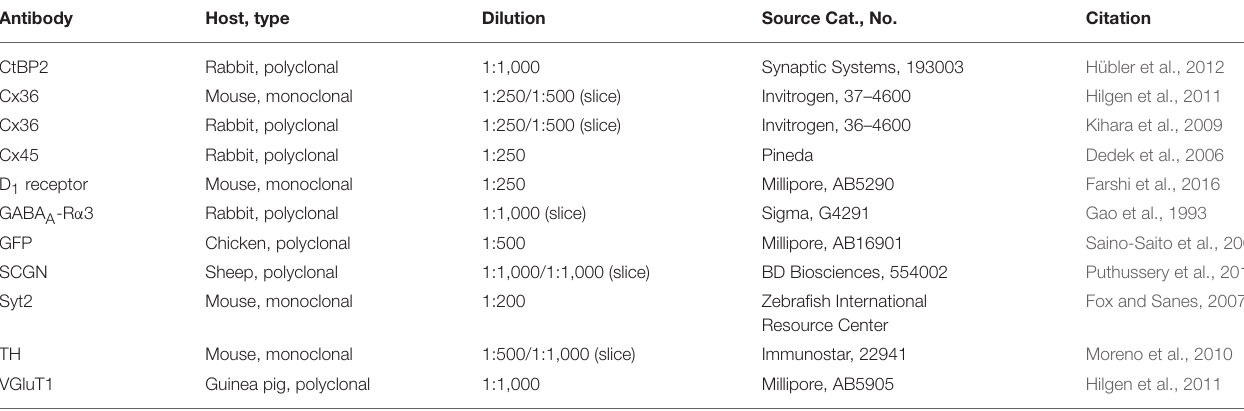
TABLE 1 | List of primary antibodies used in this study. Antibody